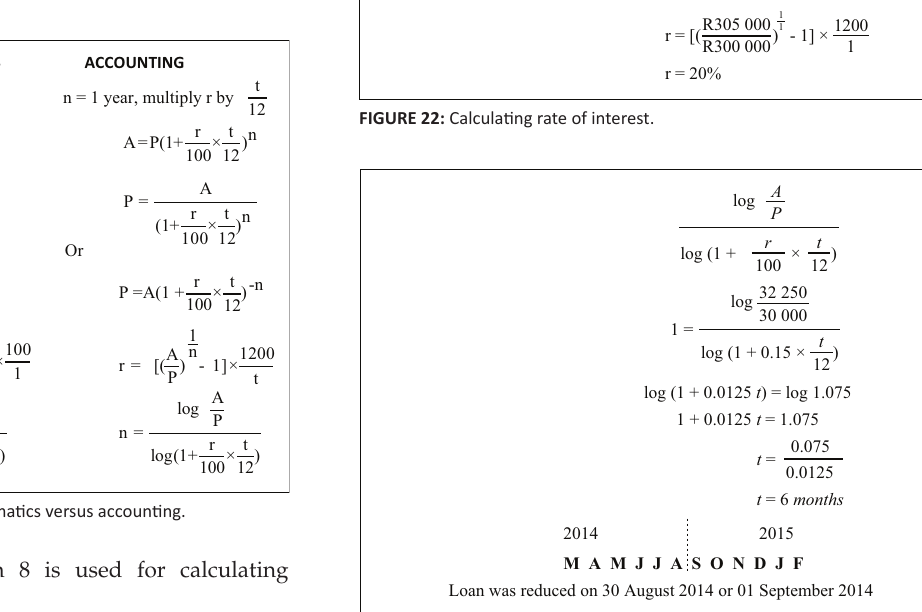
FIGURE 20 : Simple interest – Mathematics versus accounting.